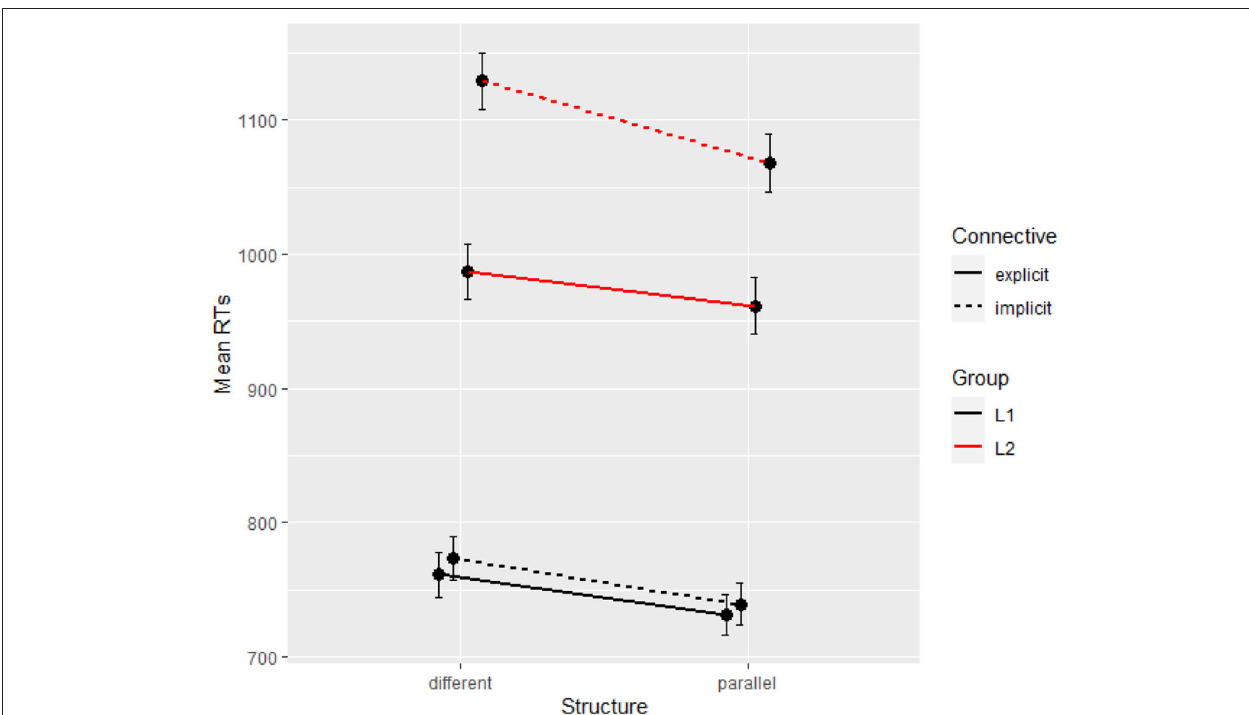
FIGURE 1 | Mean reading times per condition and per group (Experiment